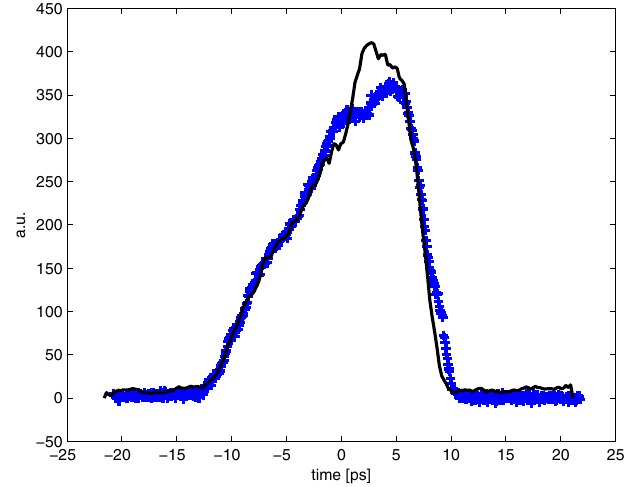
FIG. 5. (Color) Comparison of the longitudinal profile of the electron bunch measured with the transversely deflecting cavity LOLA (blue crosses) and the optical-replica synthesizer